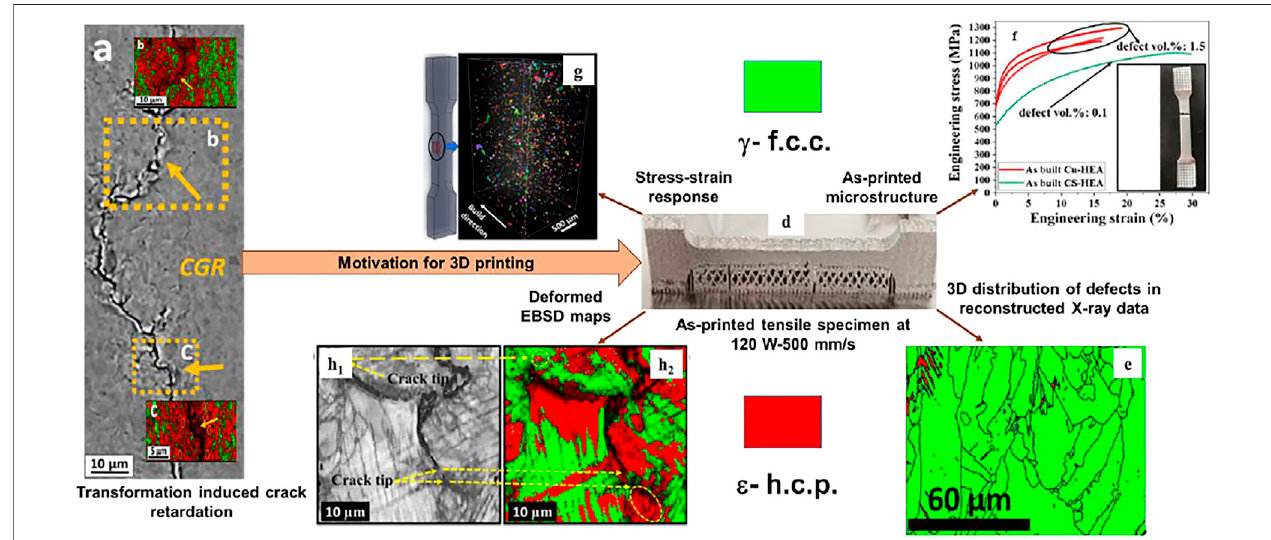
FIGURE 4 | Damage tolerance in Cu-HEA after 3D printing: (A) Transformation induced crack retardation in ultra fi ne grained Cu-HEA. (B and C) Localized γ → ε transformation within the crack tip plastic zone (Liu et al., 2019). (D) 3D printed Cu-HEA tensile specimen using LPBF technique at the parameters of 120 W and 500 mm/s(Thapliyal etal.,2020). (E) X-raymicroscopy3D reconstruction representingthedistribution ofmicrocracks andpores withinas-builtCu-HEA(Thapliyalet al., 2020). (F) Engineeringstress – strainresponse ofas-buildCu-HEA(Thapliyalet al.,2020). (G) EBSD phasemap showingthemicrostructureofas-built Cu-HEA. (h 1 and h 2 ) EBSD phase map showing localized γ → ε transformation near the crack type defects in as-deformed Cu-HEA (Thapliyal et al., 2020).